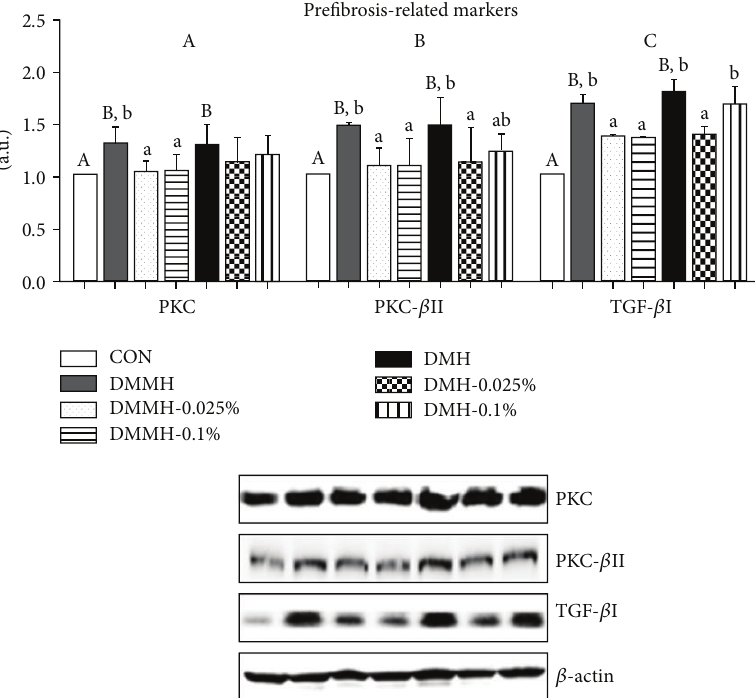
Figure 5: Effect of genistein supplementation on the kidney protein levels of PKC (a), PKC- 𝛽 II (b), and TFG- 𝛽 I (c) in experimental mice. All results were conducted at least three times. Data are presented as means ± SD ( 𝑛 = 9 -10/group). Mean values with different letters were significantly different, 𝑃 < 0.05 . Statistical differences of variables among CON, DMMH-C and DMH-C analyzed by one-way ANOVA were shown in capital letters and effects of the genistein supplemented diet and/or DM severity using two-way ANOVA was represented by small